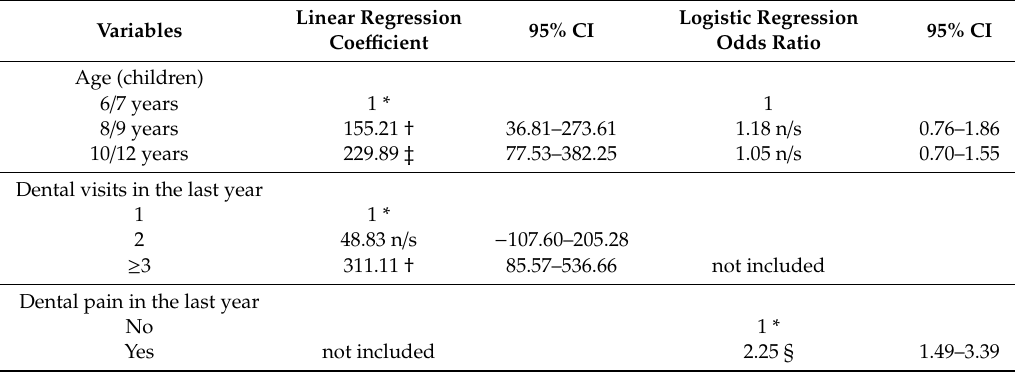
Table 6. Multivariate linear regression models (that modeled the amount of OOPEs) and a logistic regression model (that modeled the likelihood of incurring